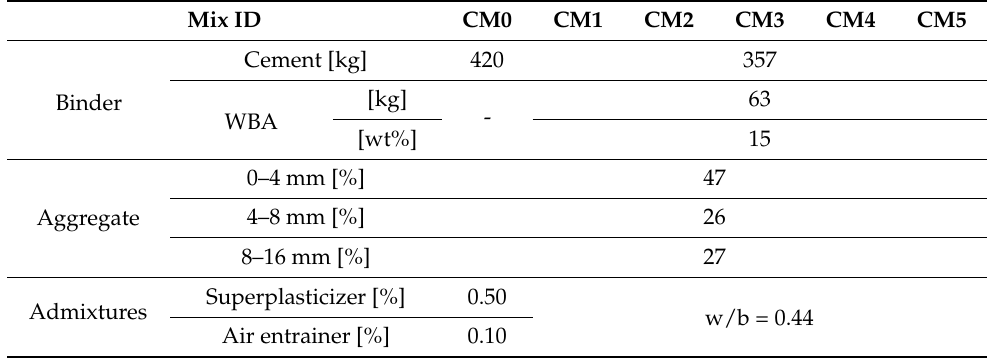
Table 2. Concrete mix design.